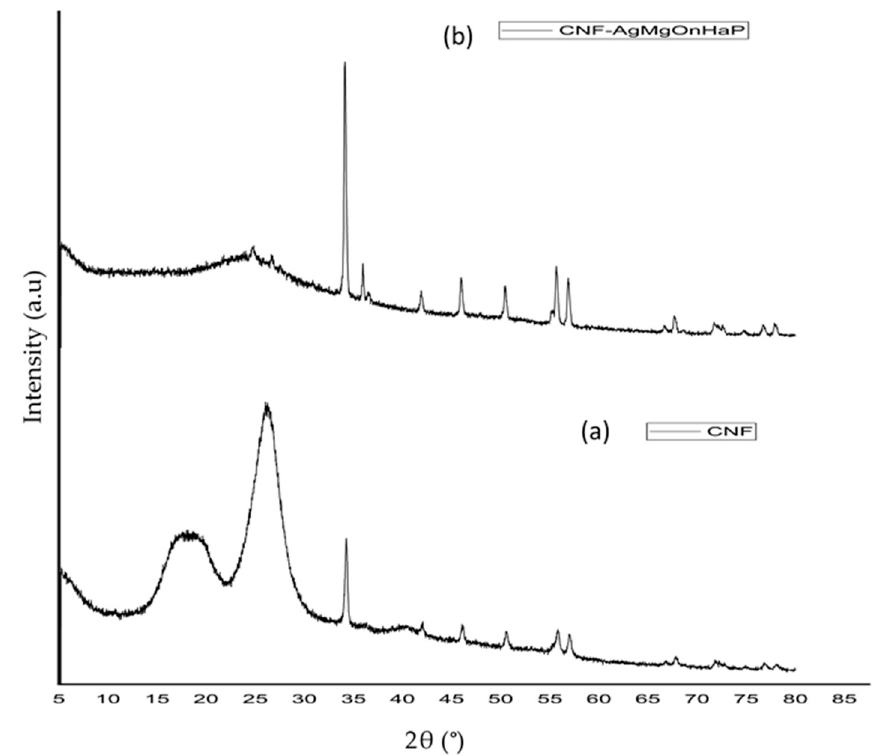
Figure 5. XRD patterns of ( a ) CNF from sawdust ( b ) CNF-AgMgOnHaP